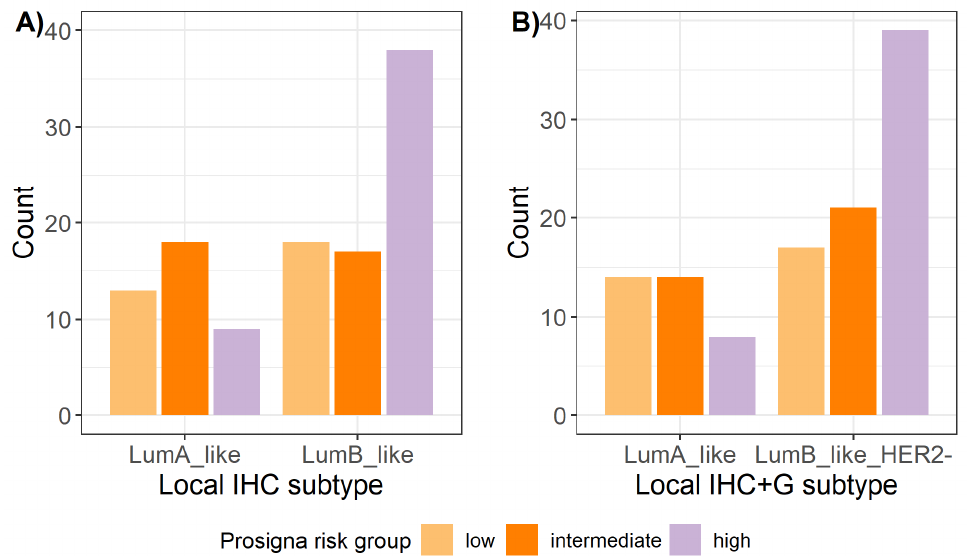
Figure 3. Distribution of Prosigna®risk groups across local surrogate ( A ) IHC subtypes and ( B ) IHC+G subtypes. IHC = immunohistochemistry; IHC+G = immunohistochemistry + tumor grade; LumA = Luminal A; LumB = Luminal B.